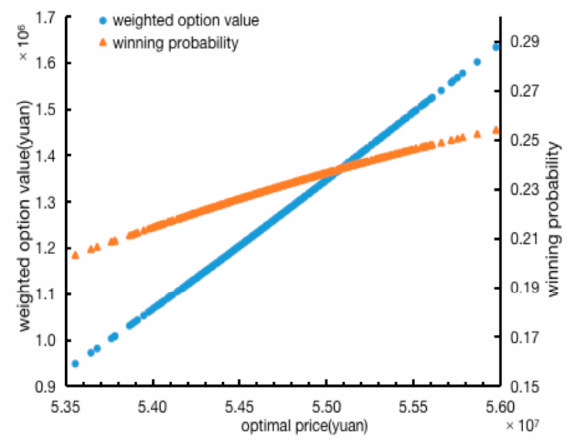
Figure 3. Concentration of the optimal bidding price.